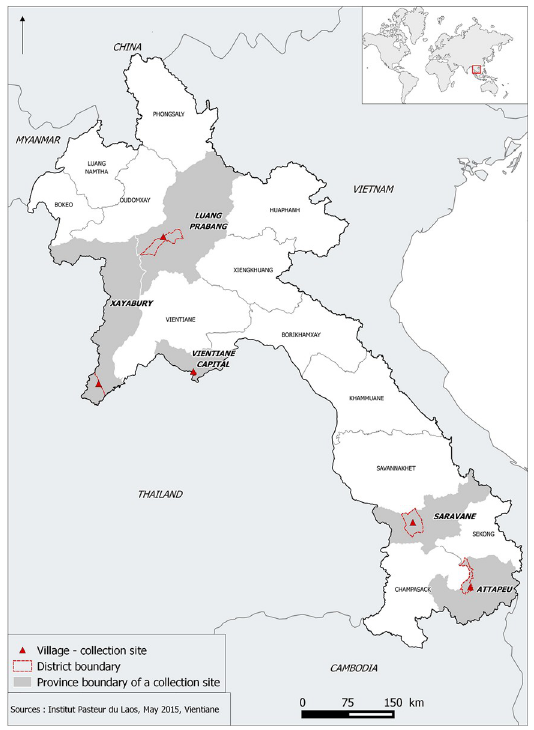
Fig 1. Locations of the mosquito collection sites. Source: MALVEC Project 2016, Institut Pasteur du Laos—IRD, SavGIS software.